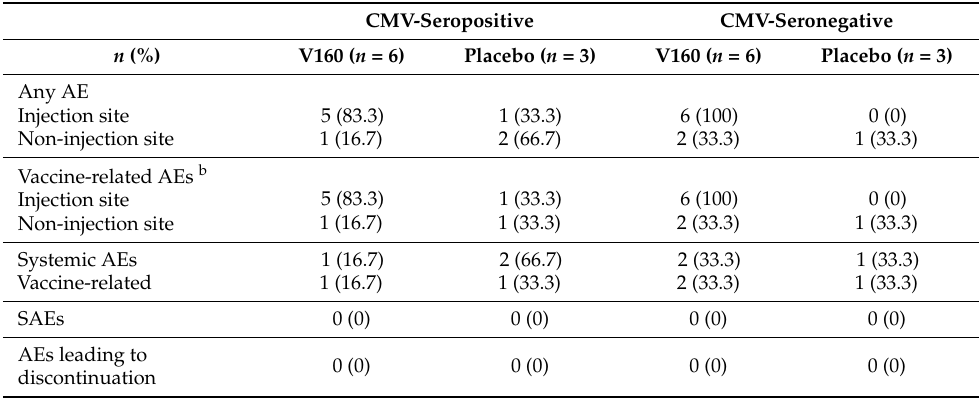
Table 2. Solicited and unsolicited post-vaccination AEs a